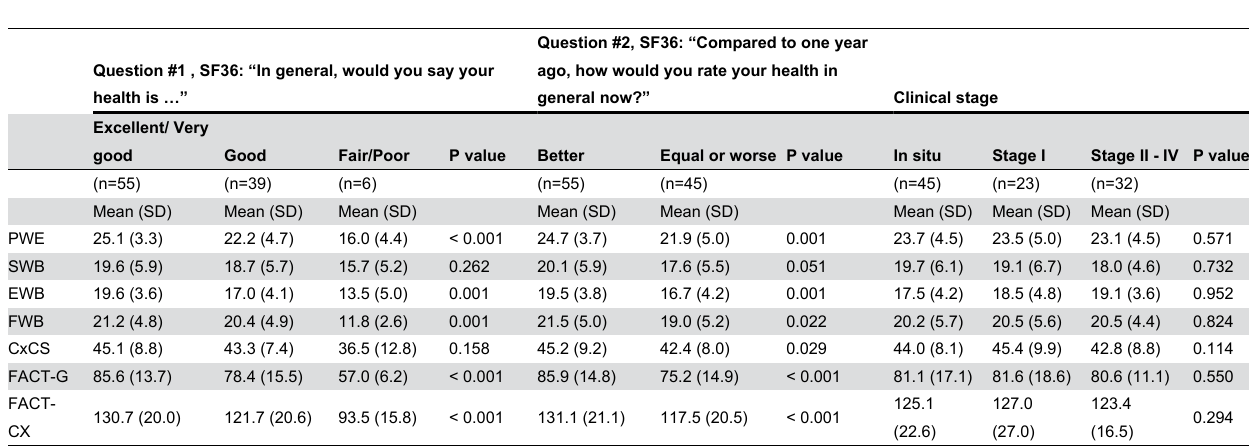
Table 7. Comparison of means of FACT-CX scales according to the clinical stage and SF-36 questions number 1 and 2 (discriminant